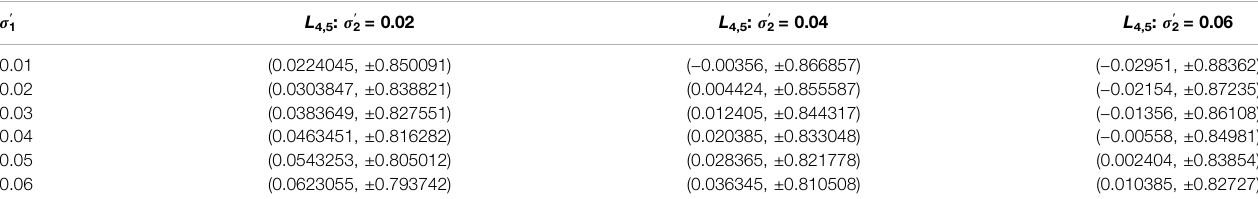
TABLE 11 | Positions ( x 0 , ± y 0 ) of the two triangular points L 4 and L 5 of the binary HD155876 system for three fi xed values of σ 2 ′ when σ 1 ′ varies. The radiation pressure, oblateness, mass of the disc, and triaxiality parameters of the bigger primary are kept as constants as in the collinear case (Table 10) . 9 L σ 1